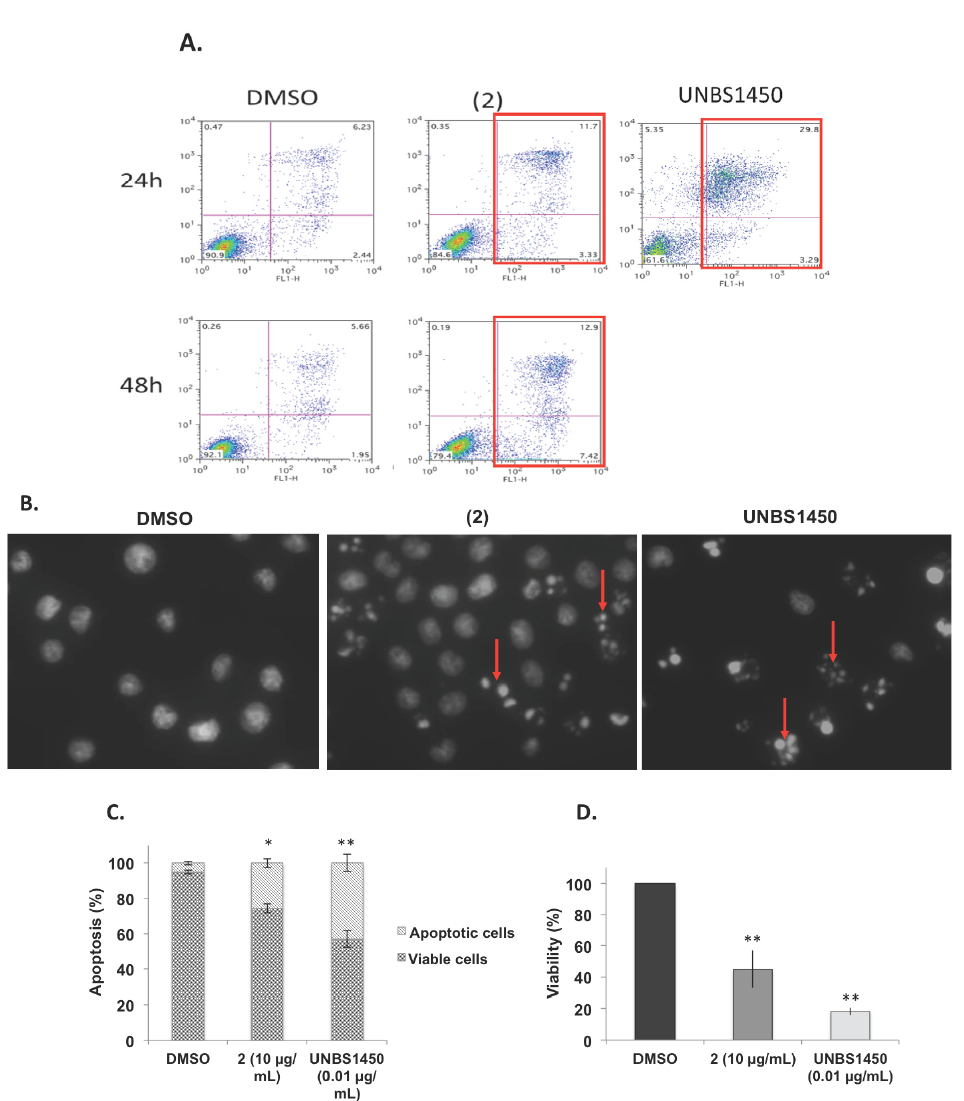
Figure 7. ( A – D ): Apoptotic effect of compound 2 at 10 µ g/mL and UNBS1450 at 0.01 µ g/mL, 24 h on U937 cells. U937 cells treated with (2) at 10 µ g/mL, dimethyl sulfoxide (DMSO) (negative control) or UNBS1450 at 0.01 µ g/mL (positive control) were subjected to an Annexin V/PI staining assay. Results were confirmed by three independent analyses, the red squares indicate the cytotoxic effect ( A ); Hoechst staining of U937 cells treated with DMSO or (2) at 10 µ g/mL compared to UNBS1450. Nuclear fragmentation (indicated by red arrows) is observed in cells treated with (2) or UNBS1450 ( B ); apoptotic effect of (2) at 10 µ g/mL or UNBS1450 (positive control) was evaluated by Hoechst staining assay ( C ), compared to its cytotoxicity evaluated by trypan blue exclusion test ( D ). Data are the mean ˘ SD (Standard Deviation) of three independent